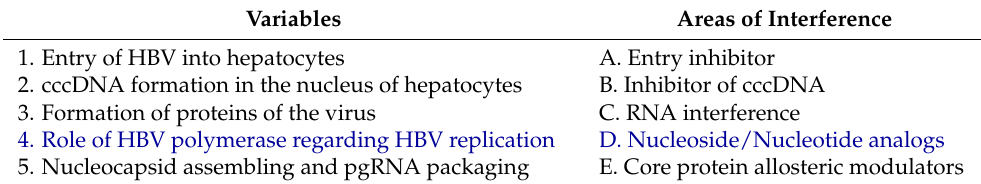
Table 1. Comprehensive stages of HBV